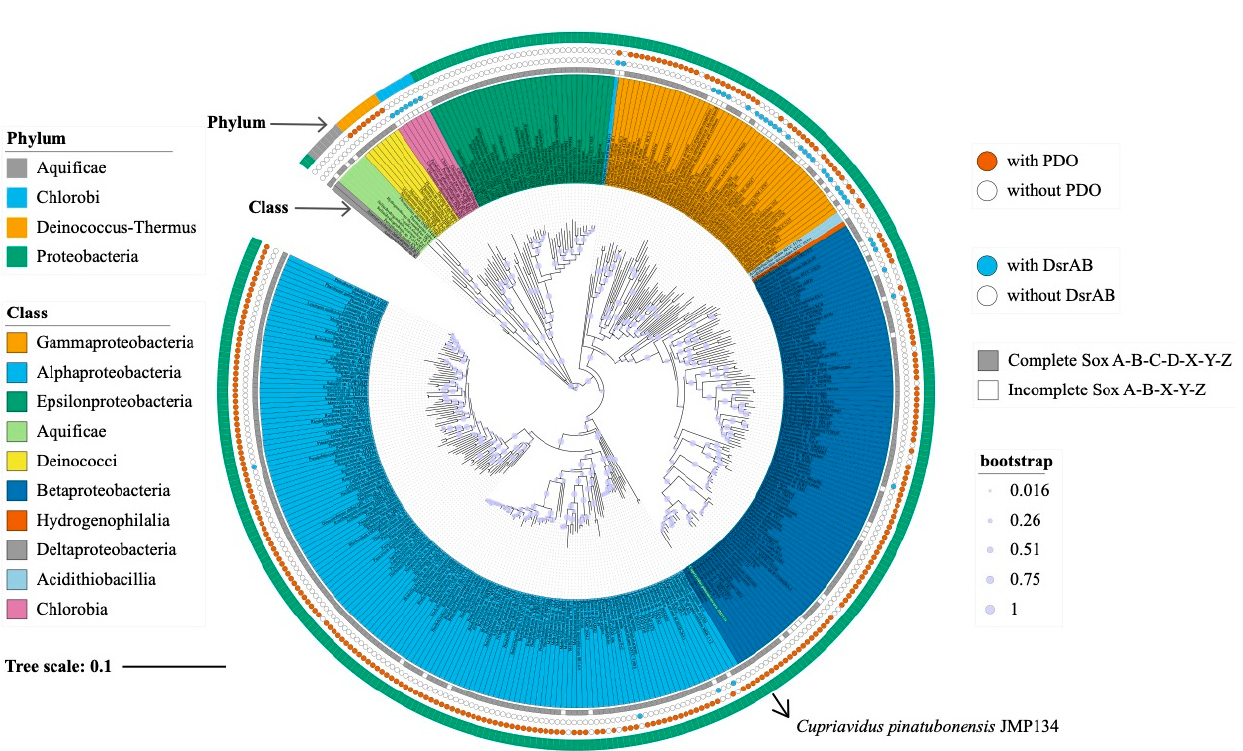
Figure 6. Phylogenetic tree based on 16S rRNA gene sequences. The neighbor-joining tree was calculated using an alignment of 362 representative 16S rRNA gene sequences of species containing complete and incomplete Sox systems. These sequences were aligned using the Muscle script, and the tree was built by using MEGA11 with pairwise deletion and p-distance distribution. Bootstrap analysis was performed with 1000 replicates. All 362 species are labeled, and different backgrounds represent lineage classes. Outside of the tree, the first ring (gray box) represents the integrity of the Sox system. The second (blue circle) and third ring (red circle) denote the presence or absence of PDO and DsrAB on the genome of a corresponding species, respectively. The outermost ring represents the lineage phylum of these 362 species. Circles on tree branches represent the percentage of bootstrap